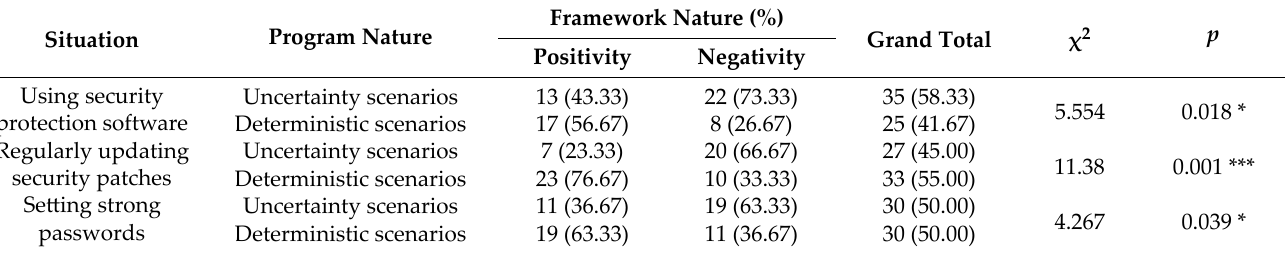
Table 17. Results of Cross‑Tabulation (Chi‑Square)